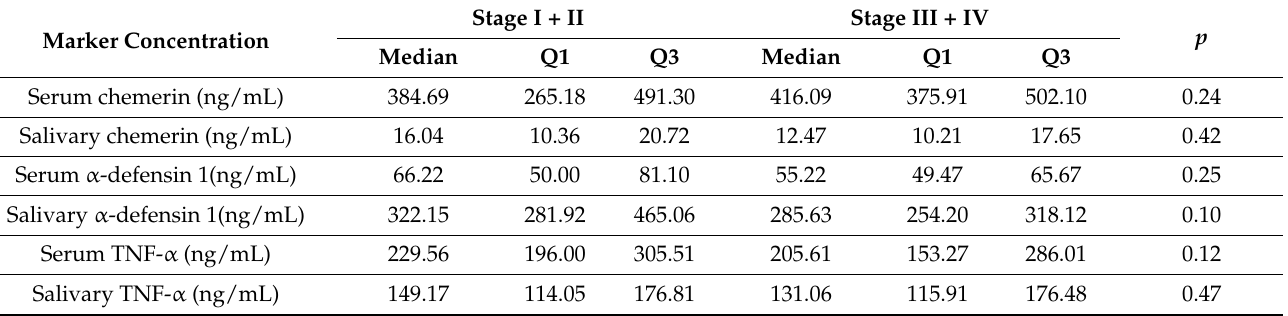
Figure 3). Patients with G3 grade had lower serum chemerin concentrations and higher serum α -defensin 1 and salivary TNF- α